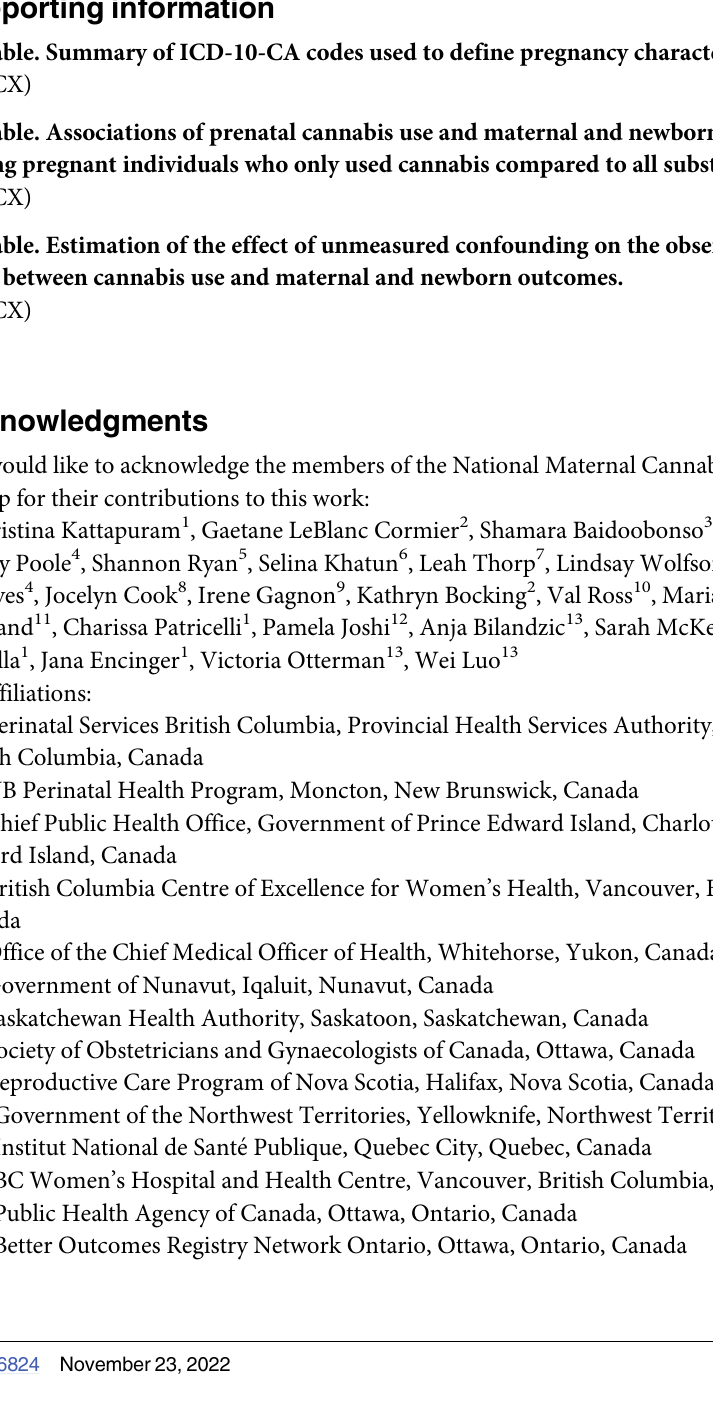
S1 Table. Summary of ICD-10-CA codes used to define pregnancy characteristics. S2 Table. Associations of prenatal cannabis use and maternal and newborn outcomes among pregnant individuals who only used cannabis compared to all substance use. S3 Table. Estimation of the effect of unmeasured confounding on the observed associa- tions between cannabis use and maternal and newborn